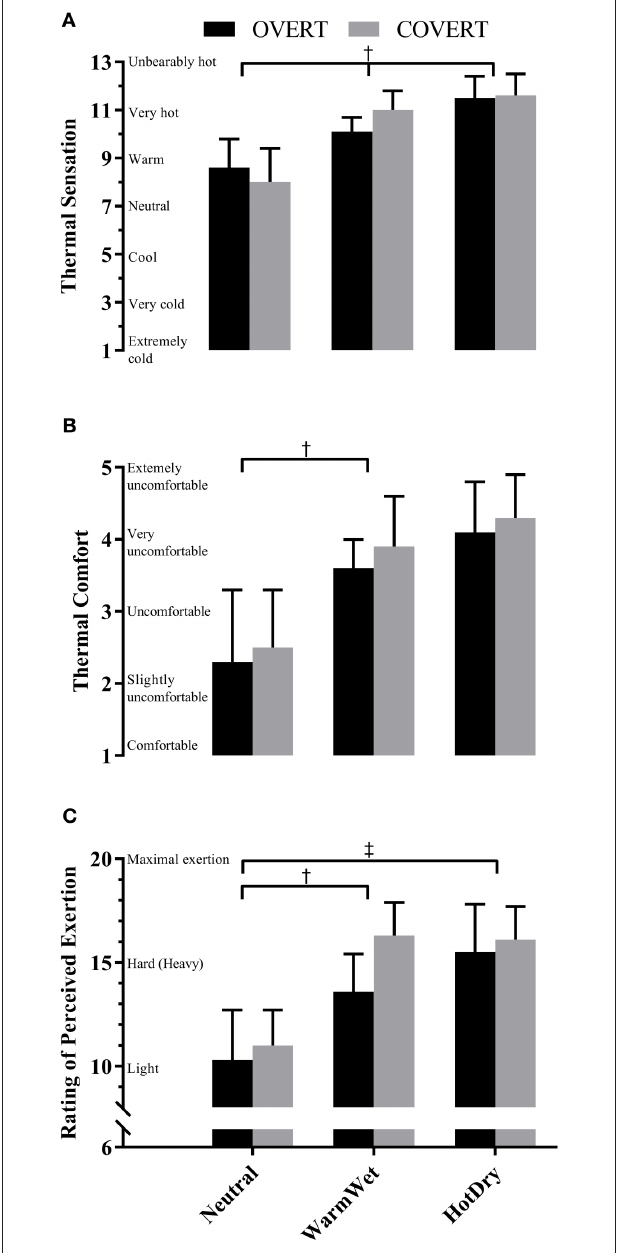
FIGURE 2 | Mean (SD) thermal sensation (A) , thermal comfort (B) and rating of perceived exertion (C) in each CBRN ensemble and environment. † main effect for environment, ‡ main effect for ensemble ( P <